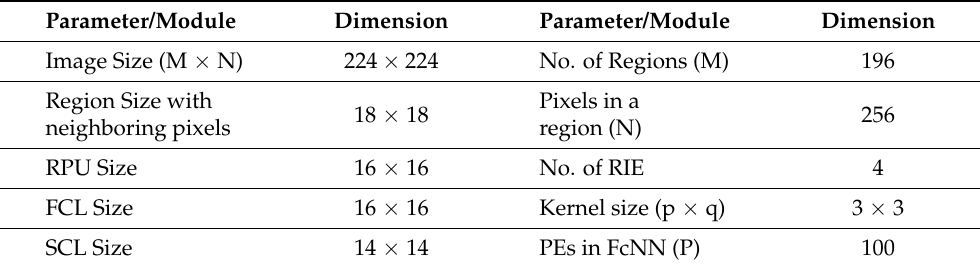
Table 3. Parameters used in this